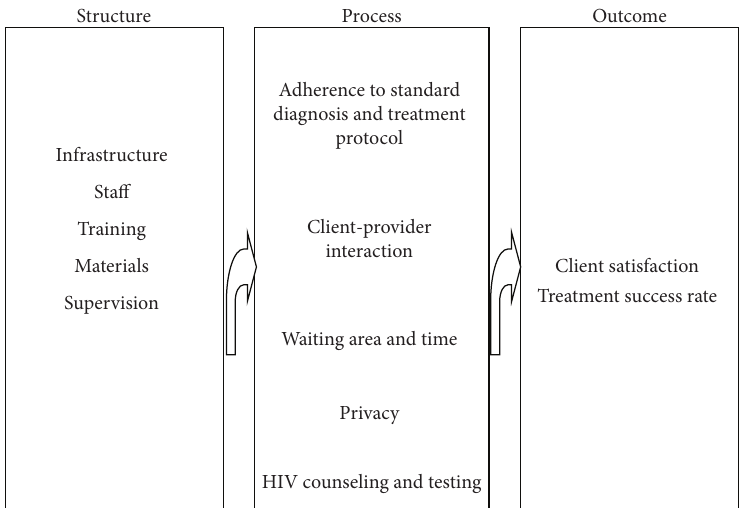
Figure 1: The conceptual framework for assessing quality of TB care in private health facilities of Addis Ababa, Ethiopia 2011.